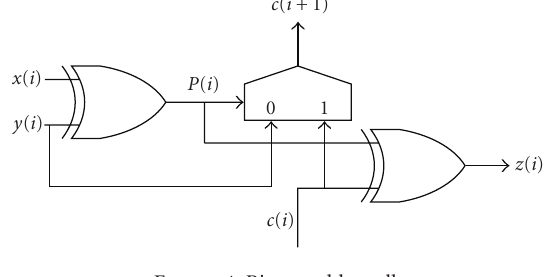
Figure 4: Binary adder